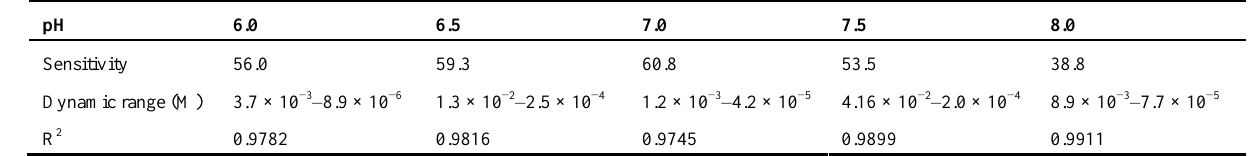
Table 3. Influence of pH on biosensor response using 5 × 10 −4 M PBS.